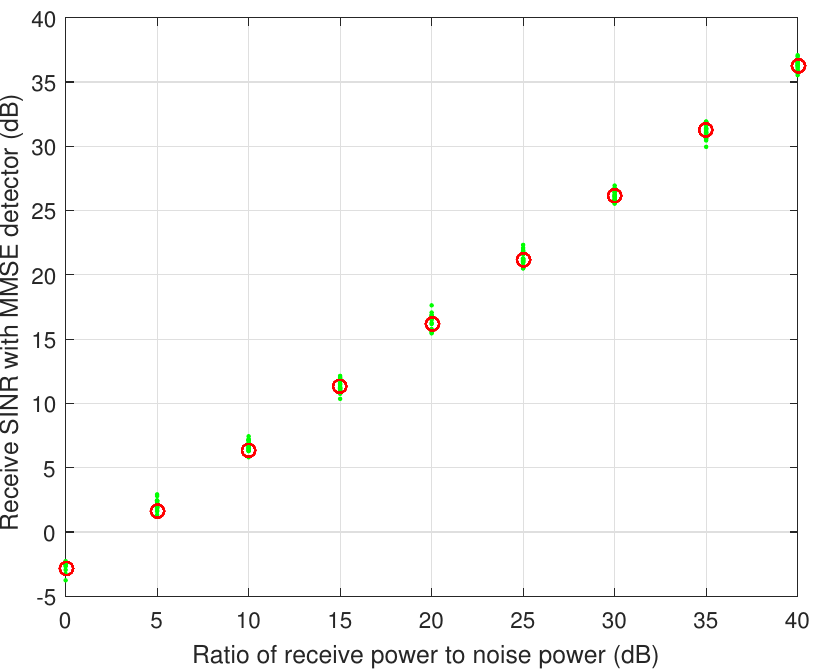
Figure 2. Received SINR with MMSE detector vs. received SNR, i.e., q theoretical results.